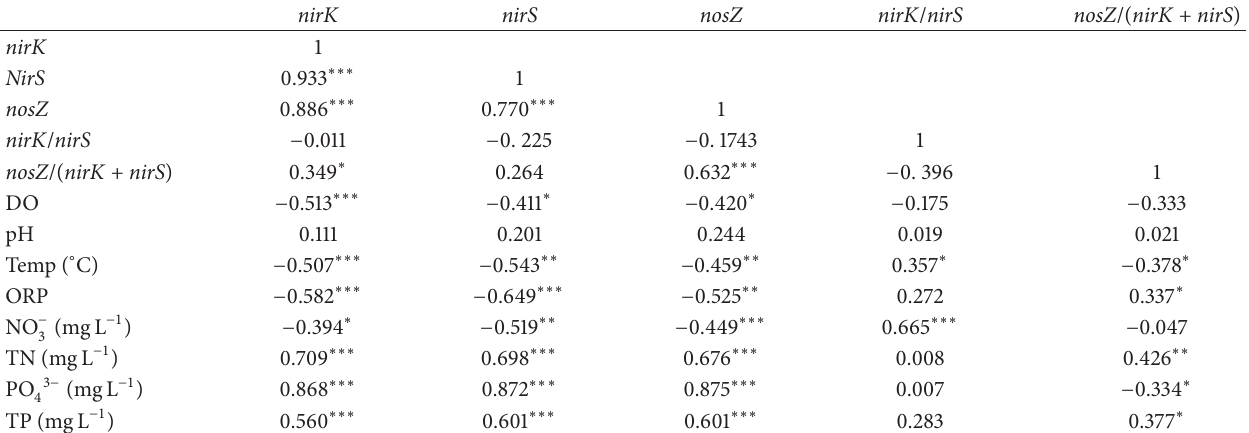
Table 5: Correlations between abundance and parameters for denitrifying genes in the